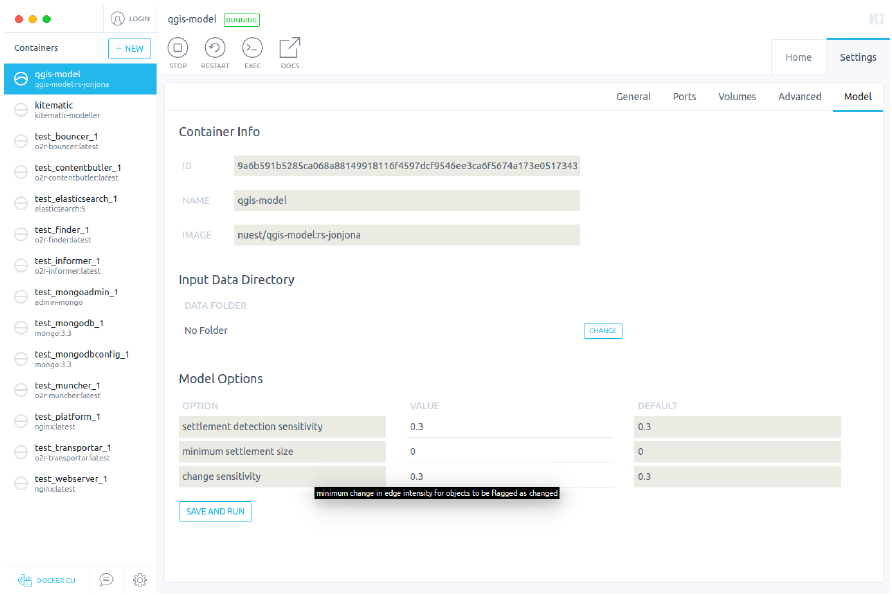
Figure 6. Screenshot of extended Kitematic software. The left-hand side lists locally available containers and the currently-selected one is highlighted in blue. At the top, buttons control the container state. Two nested levels of tabs show information on and allow configuration of the selected container. The tab “model” is active and was developed as part of this work. Its contents in the central area of the UI provide a form-based user interface for controlling parameterized GEOBIA workflows. The list of model options (bottom) shows the option name, current value and default value. A pop-up displays an information text for the third option as the cursor hovers over that line. A "Save and run" button at the bottom can be used to restart the analysis with the changed